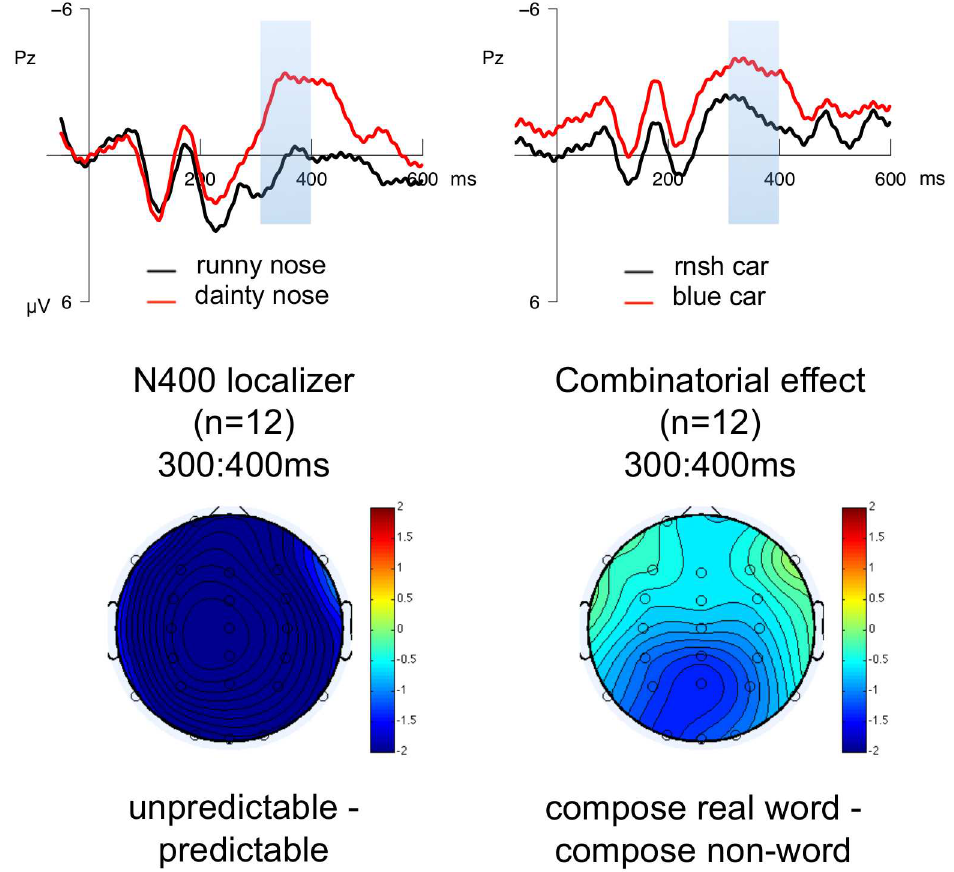
Fig 6. Comparison of ERPs for N400 localizer and main experiment. The upper panels show the waveforms and, and the bottom panels show the topographical distributions for the N400 localizer experiment and the combinatorial effect in the compose task, for the 12 participants who participatedin both experiments. Waveforms illustrate the responsesat representative electrodePz. Scalp maps illustrate the estimated activity resulting from the subtractions (unpredictable—predictable)and (real word—nonword) in the 300:400ms